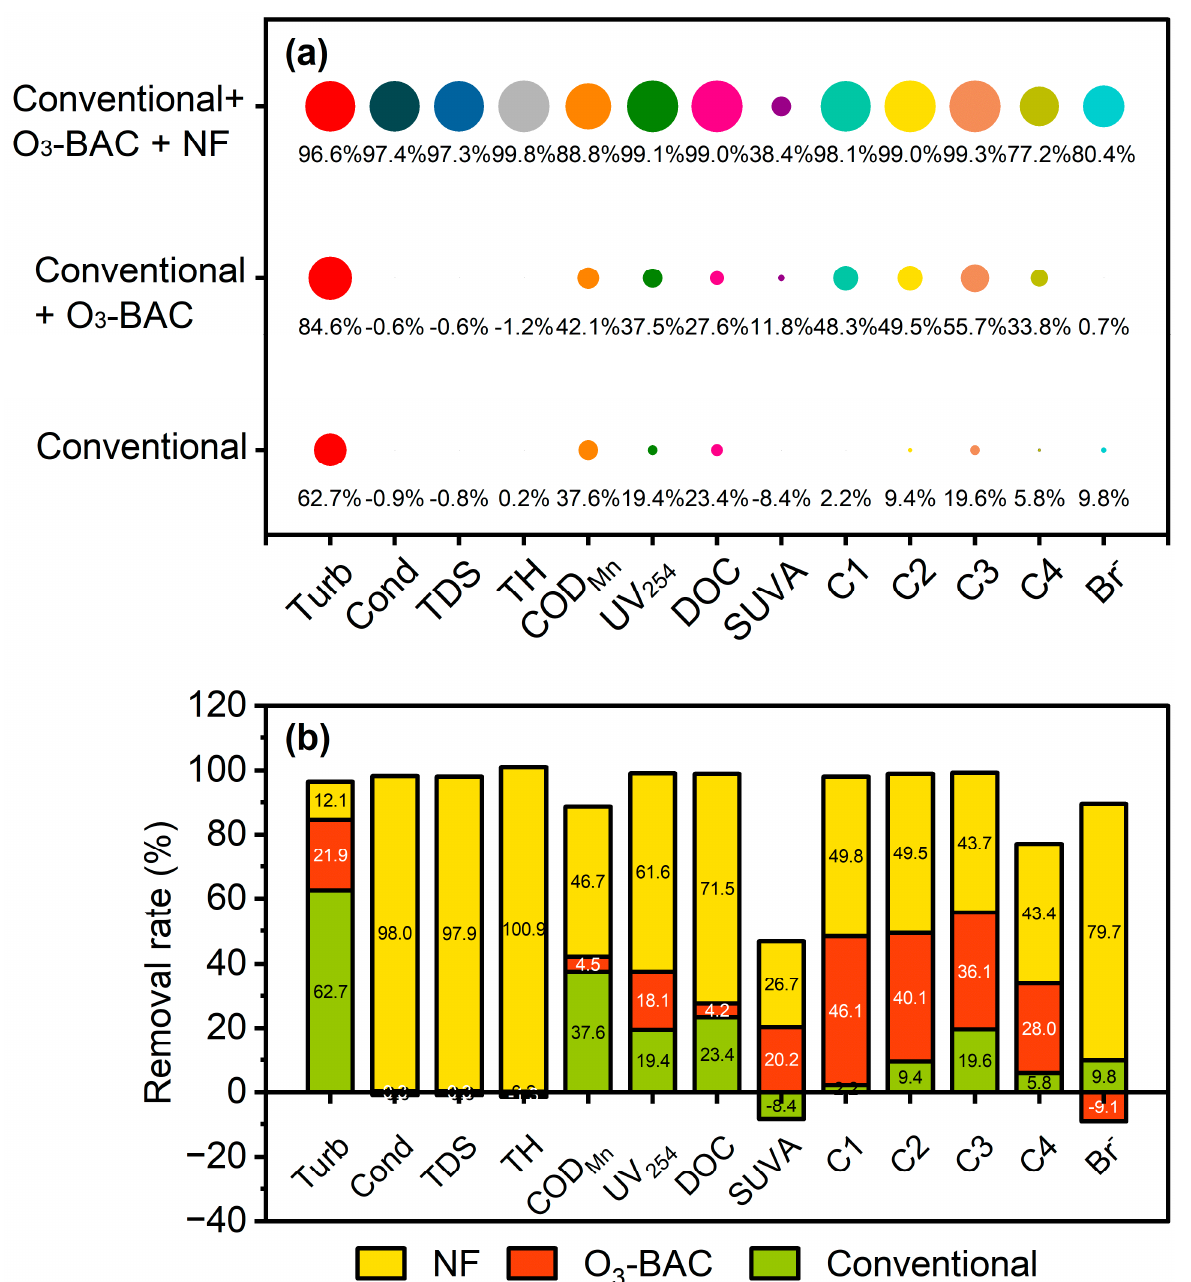
Figure 2. Removal efficiencies of water quality parameters by the treatment processes at the full-scale DWTP plus the pilot-scale NF system: ( a ) accumulative removal efficiencies by the conventional, conventional + O 3 -BAC, and conventional + O 3 -BAC + NF processes; and ( b ) individual removal efficiencies by conventional, O 3 -BAC, and NF processes. Samples from both the full-scale and pilot-scale processes were collected regularly ( n = 3 for anions, n = 14 for fluorescence measurements, and n = 17 for the rest parameters) during August 2020–December 2021. For a specific indicator, the removal efficiencies were normalized to the values of the raw water as described in the main text). For panel (a), the circles are filled with different colors for different parameters, and their sizes (circle areas) represent removal efficiencies.